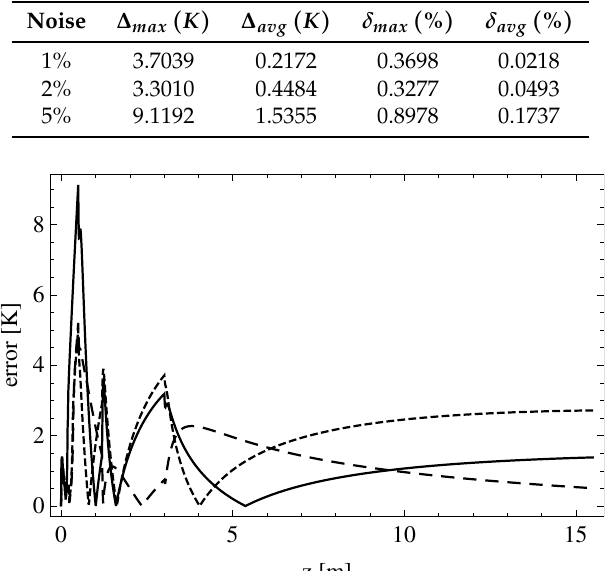
Table 4. Errors of temperature reconstruction in the control points obtained for measurements read at every 0.02m (one step optimization).